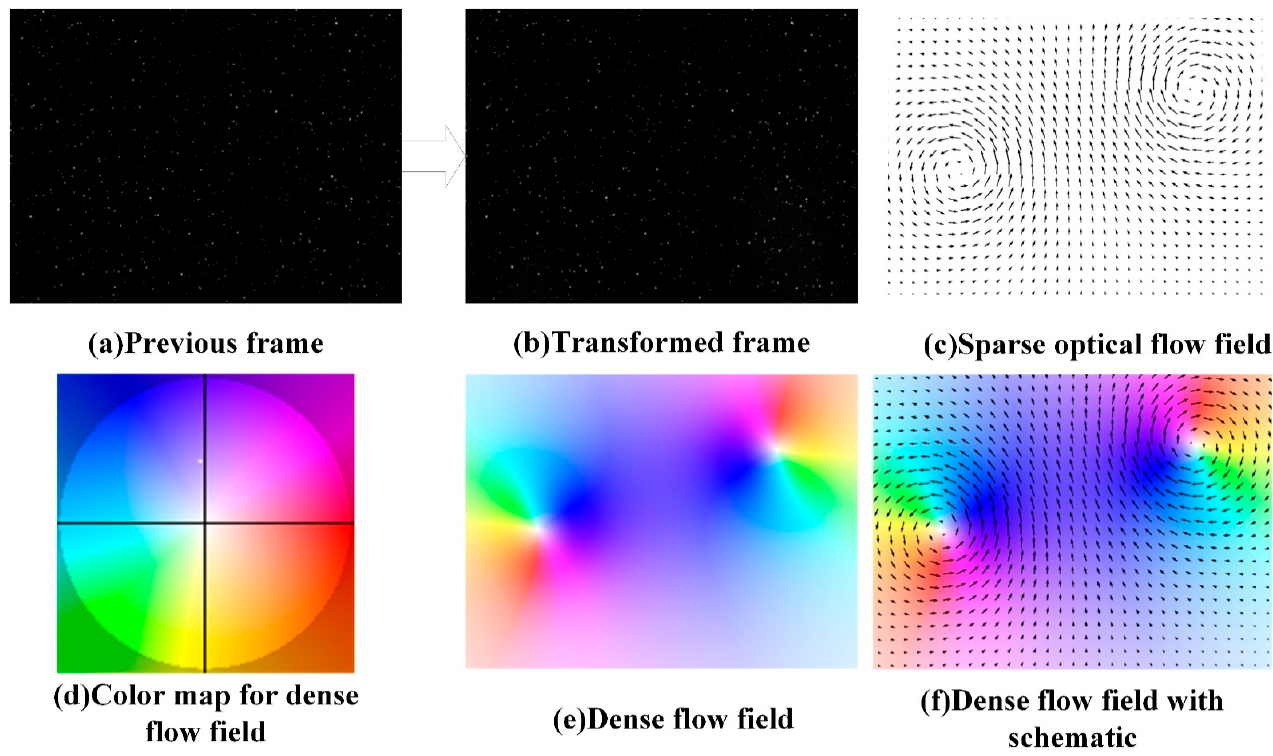
Figure 2. Schematic diagram of dense optical flow PIV simulation data generation.